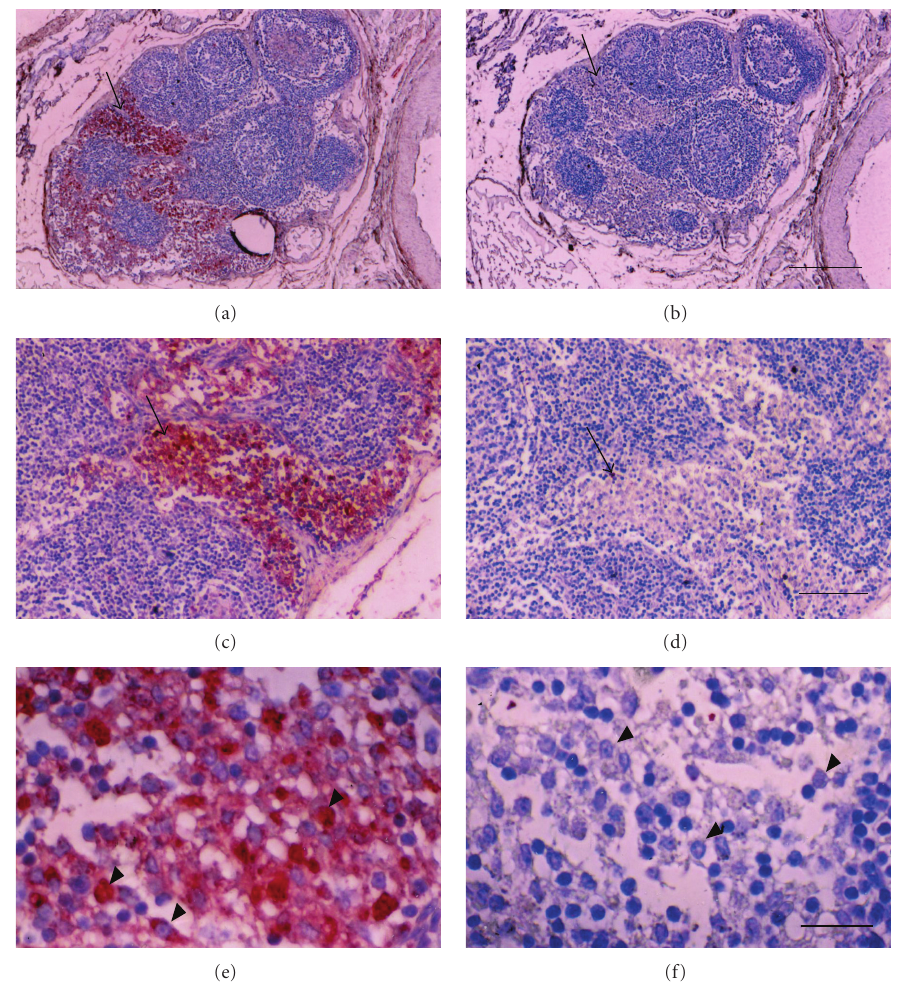
Figure 3: Photomicrographs of mesenteric lymph node from an STZ-diabetic rhesus macaque, 78 days after transplantation of E28 pig pancreatic primordia. Sections (a), (c), and (e) are stained with an anti-insulin antibody. Sections (b), (e), and (f) are stained using a control serum. Sections of medullary sinus are delineated by arrows (a–d). Individual cells with beta cell morphology are delineated by arrowheads (e) and (f). Scale bars 120 um (a) and (b); 80um (c) and (d); 20 um (e) and (f), reproduced with permission